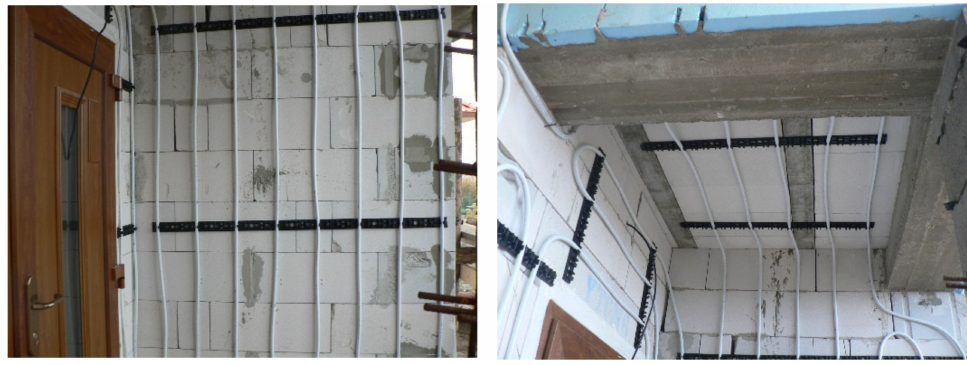
Figure 27. Placing pipes of active thermal protection on the facade. [Author: Kal ú